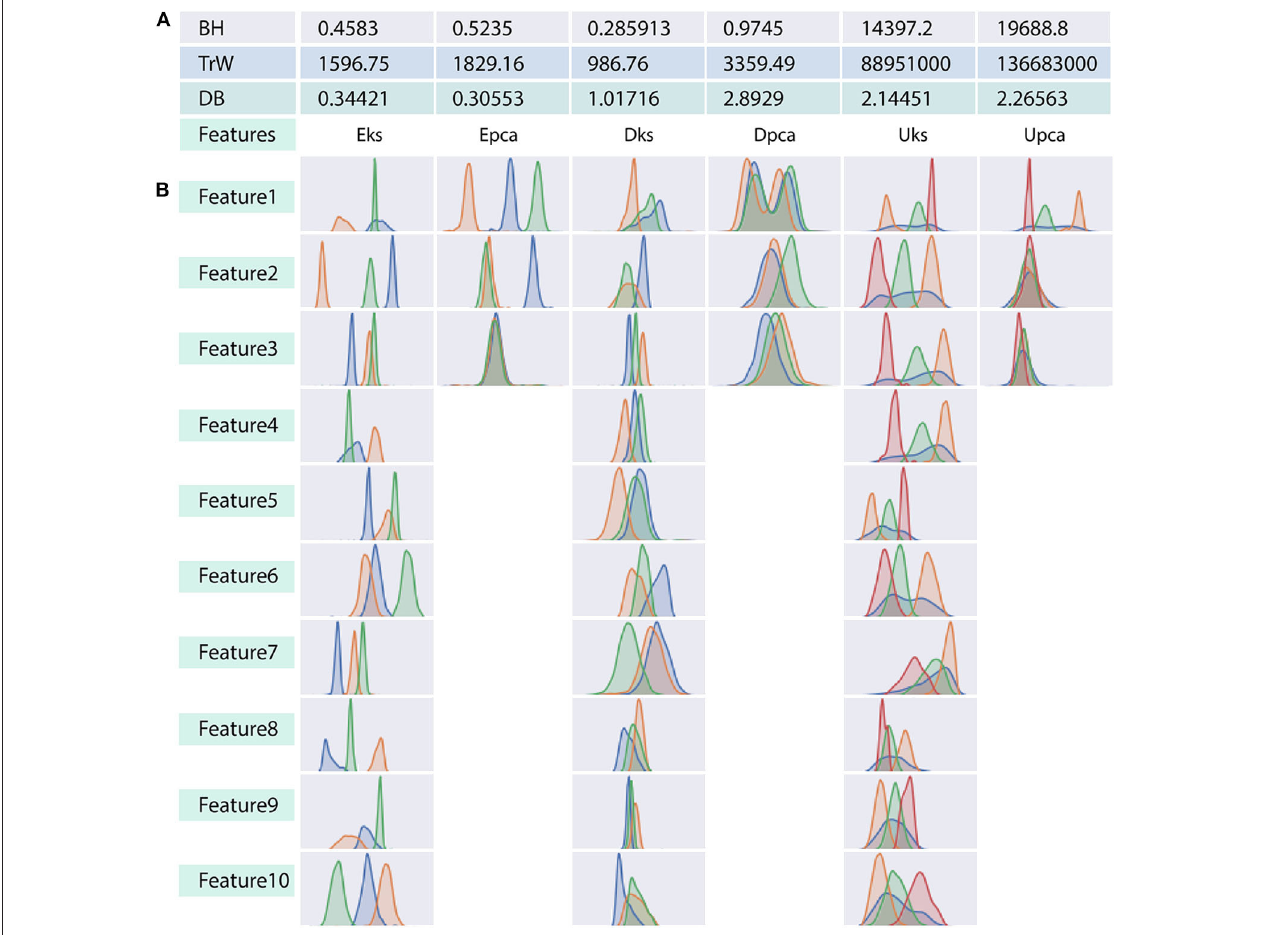
FIGURE 3 | Relation between indices values and distribution plot of clusters in each feature-set. (A) Three tabulated rows show indices generated by each of the internal validation criterion considered in the context. Indicies in (A) corresponds to the associated ground-truth of each feature-set. (B) Distribution of clusters for each dimension in any feature-set. Note that PCA constitutes only three component feature-set as opposed to ten-dimensional feature-set of the wavelet decomposition. We will refer to the overlapped region in (B) as ambiguity, which relates to the similarity between spike shapes. This ambiguity distinguishes the performance of clustering algorithms, and it is also harder even for naked eye (human operators) to judge the allocation of feature points to a